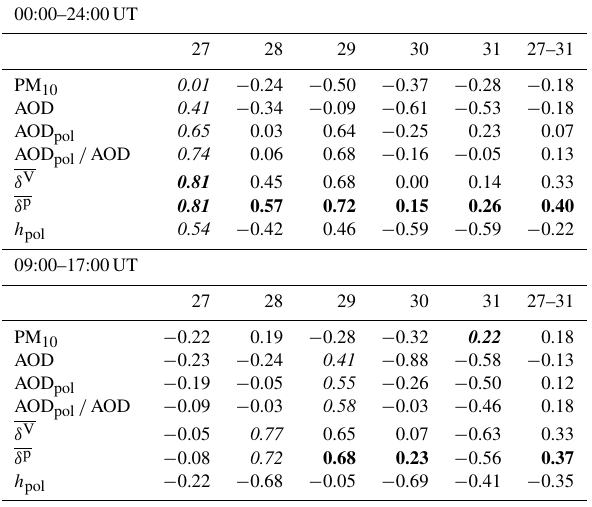
Table 2. Correlation coefficients of total pollen during the pollina- tion event calculated over the periods of 00:00–24:00 and 09:00– 17:00UT. Bold numbers indicate for each day the parameter with the highest positive correlation coefficient. Numbers in italic indi- cate for each parameter the day with the highest positive correlation